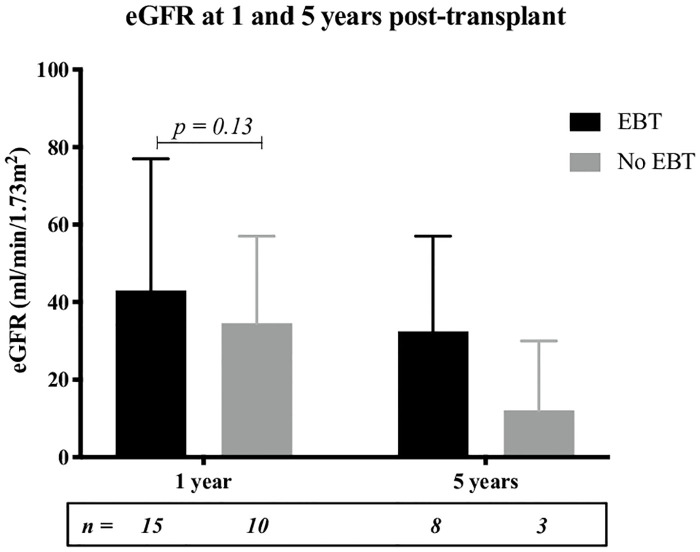
Median eGFR (calculated by MDRD/ml/min) at 1 and 5 years post transplant with and without EBT.Error bars represent range.